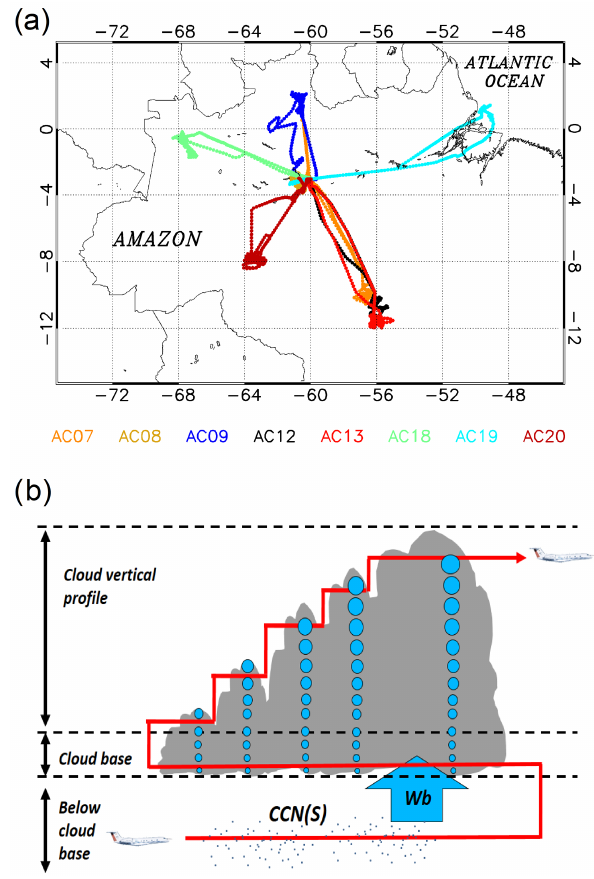
Figure 1. (a) HALO flight tracks during the ACRIDICON–CHUVA experiment. The flight number is indicated at the bottom by col- ors; (b) flight patterns below and in convective clouds during the ACRIDICON–CHUVA